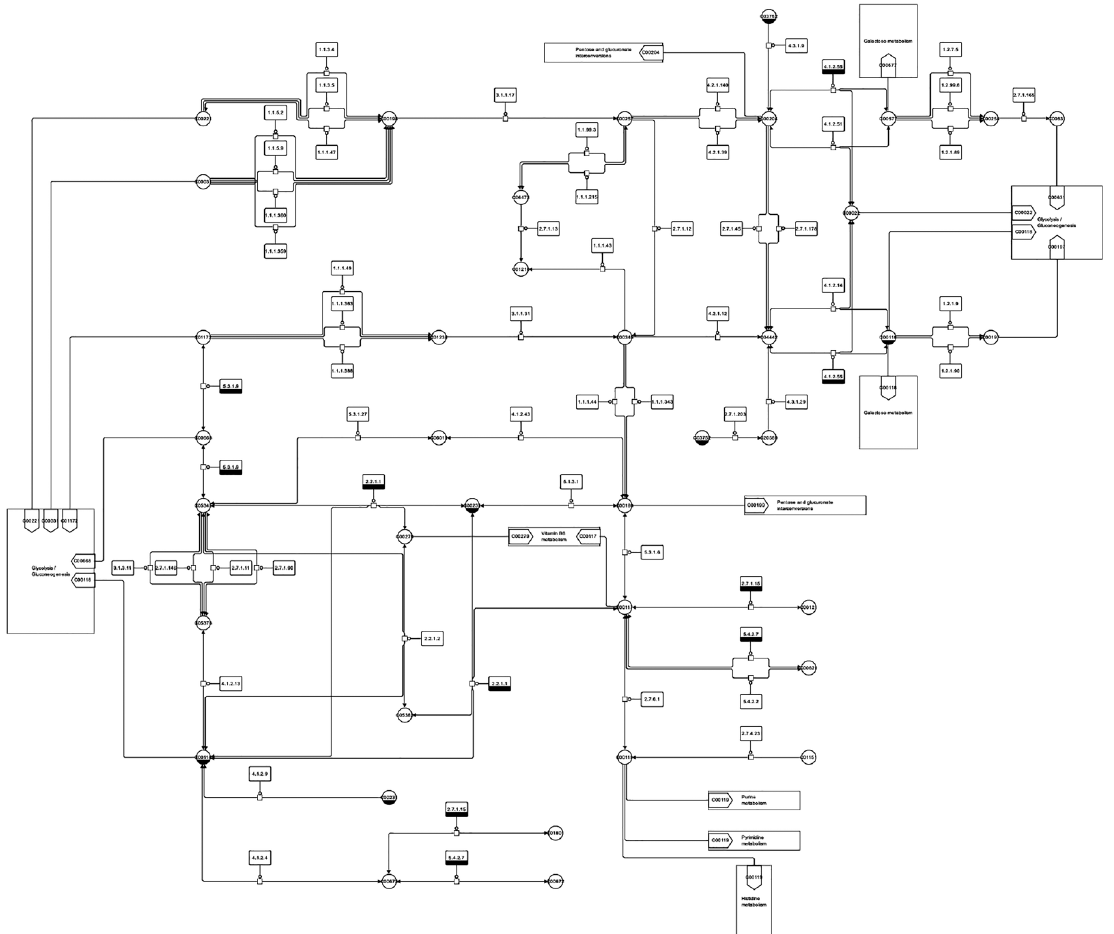
Figure 6: SBGN PD map with automatic layout derived from a KEGG